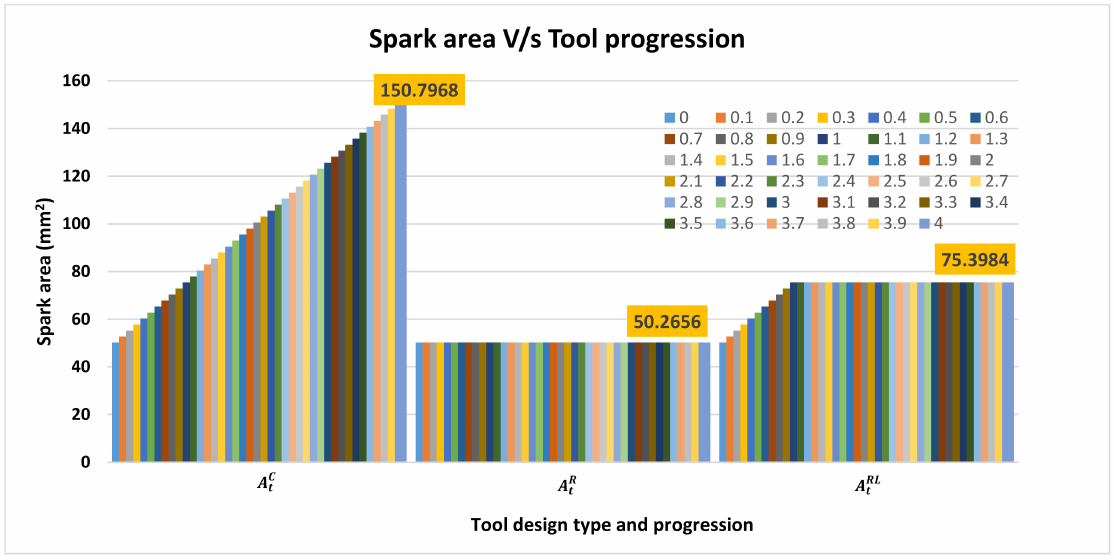
Figure 7. Validation of mathematical models presented in Equations (3), (11) and